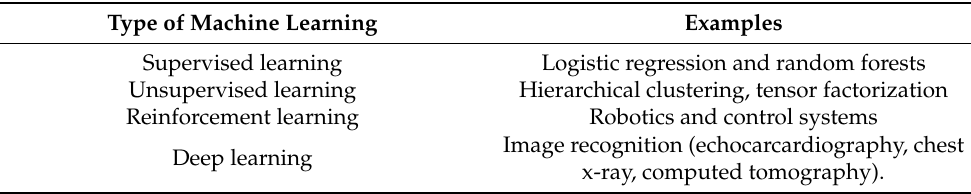
Table 1. Types of machine learning